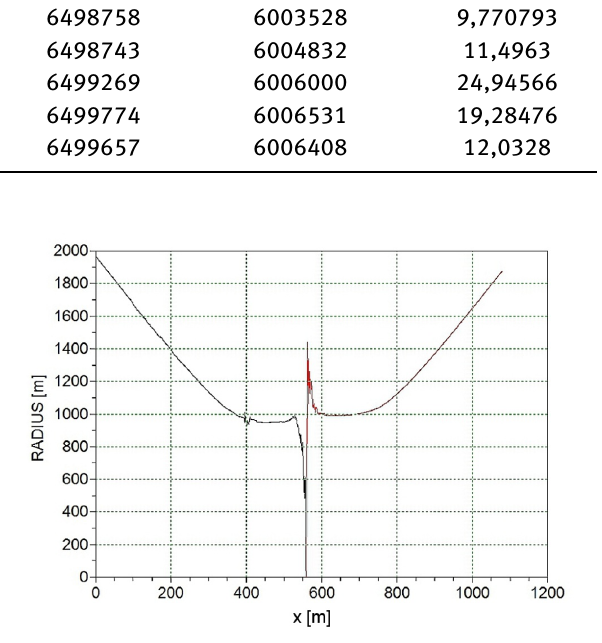
Figure 12: View of the arc area between the main directions in a local coordinate system. Figure 13: The value of radius R calculated for the left and right half